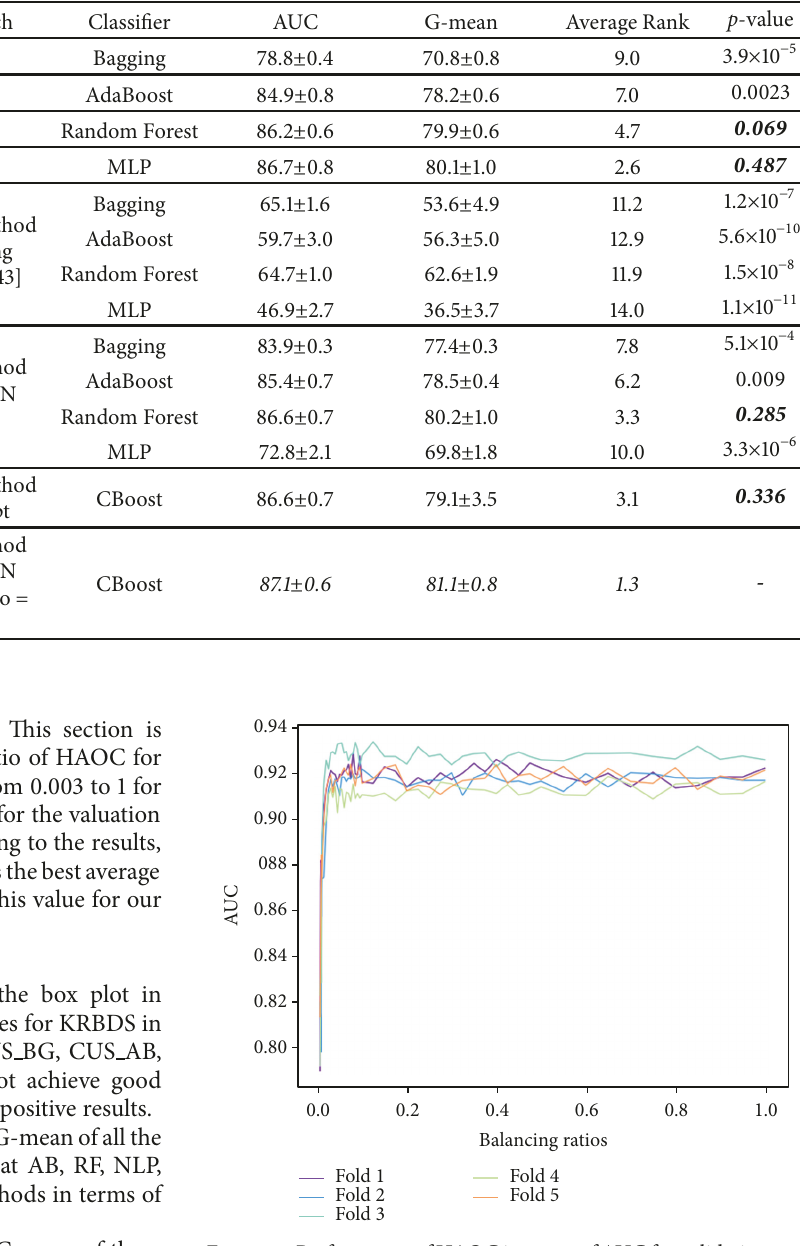
Figure7:PerformanceofHAOCintermsofAUCforvalidationsets in five